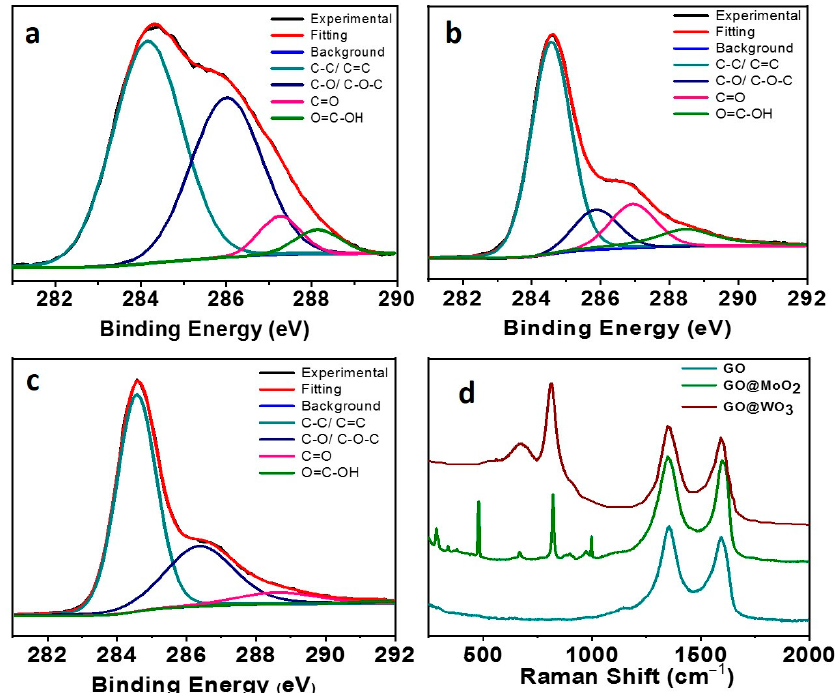
Figure 2. ( a – c ) C 1 s XPs spectra of GO, ( a ) MoO 2 @GO, ( b ) and WO 3 @GO ( c ) nanocomposite mem ‐ branes, respectively. ( d ) Raman studies of pristine GO, MoO 2 @GO, and WO 3 @GO ‐ based mem ‐